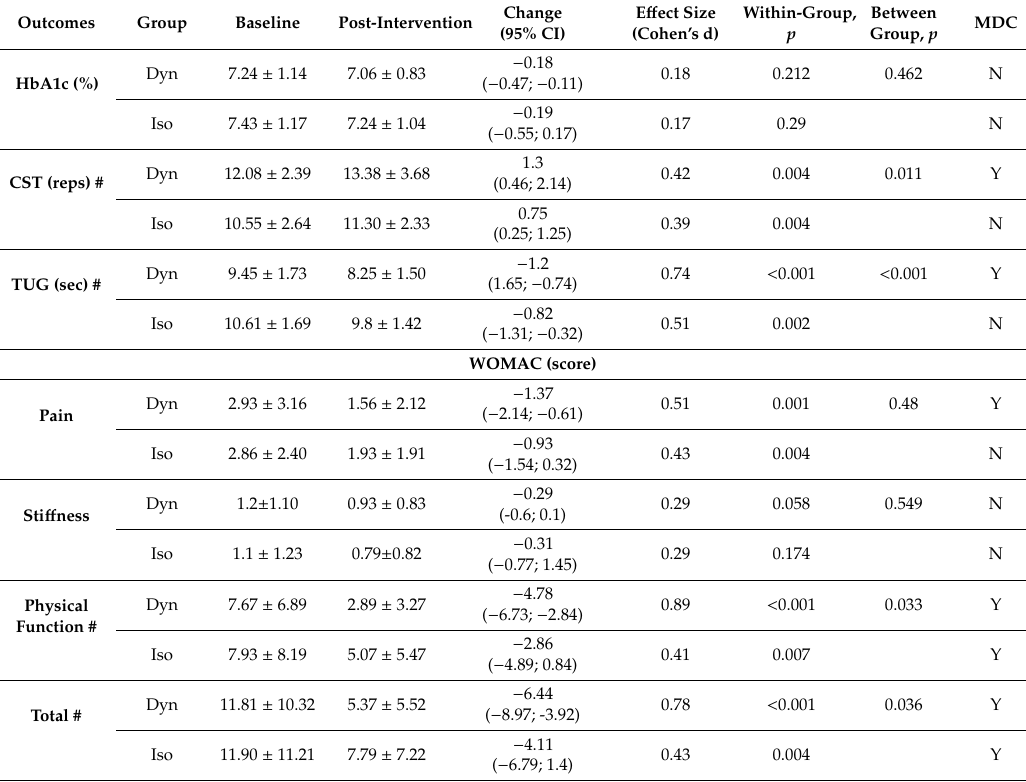
Table 2. Improvements in outcomes after the 12-week intervention between